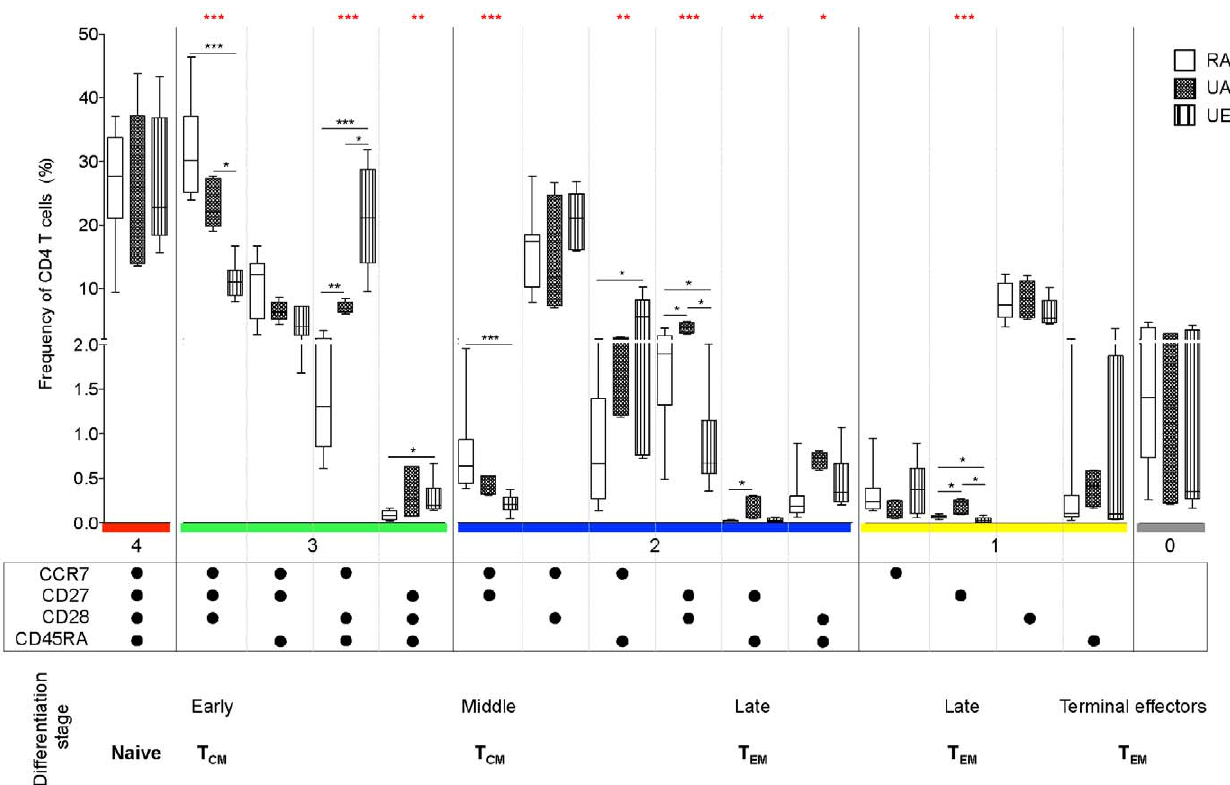
Figure 1. CD4 T cell differentiation and activation profile significantly differs between African and European donors but is similar between African individuals from either rural or urban Kenya. The differential expression of CCR7, CD27, CD28 and CD45RA by CD4 T cells was analysed by Boolean gating. Each phenotype (defined by a specific combination of markers) is shown under each subset. Each dot denotes the expression of each marker indicated on the bottom left. The differentiation stage is specified when a specific phenotype has been ascribed to a particular stage 4,13,19]. T CM and T EM refer to central memory and effector memory cells, respectively. CD4 T cell subsets were then ordered according to the number of markers they express specified by the horizontal bars of different colours showing these combinations of 4, 3, 2, 1 or 0 marker. The frequency of each subset is represented as a percentage of the total CD4 T cells (medians and 95% confidence intervals are shown for each group) and was compared between the three groups (rural African (RA, n=25), urban African (UA, n=8), and urban European donors (UE, n=8)). Differences in CD4 T cell phenotypic profile among groups were tested using Kruskal-Wallis test and where significance was obtained, nonparametric Mann-Whitney U test was used for pair-wise analysis of the differences between groups. Statistically significant P -values ( , 0.05) are indicated by an asterisk (in red for Kruskal-Wallis or black for Mann-Whitney tests, respectively). *indicates P , 0.05, **P # 0.01 and ***P # 0.001.